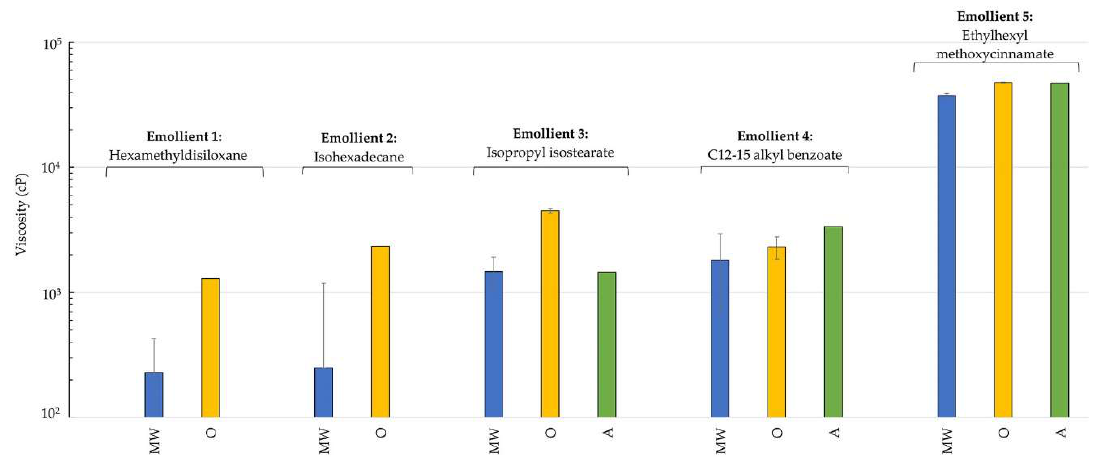
Figure 2. Viscosity of wax-emollient mixtures 24 h after formulation (average ± SD). Viscosities are compared at 9.3 s −1 for emollients 1–4, and at 0.93 s −1 for emollient 5. MW: microcrystalline wax, O: ozokerite, A: alkenones.